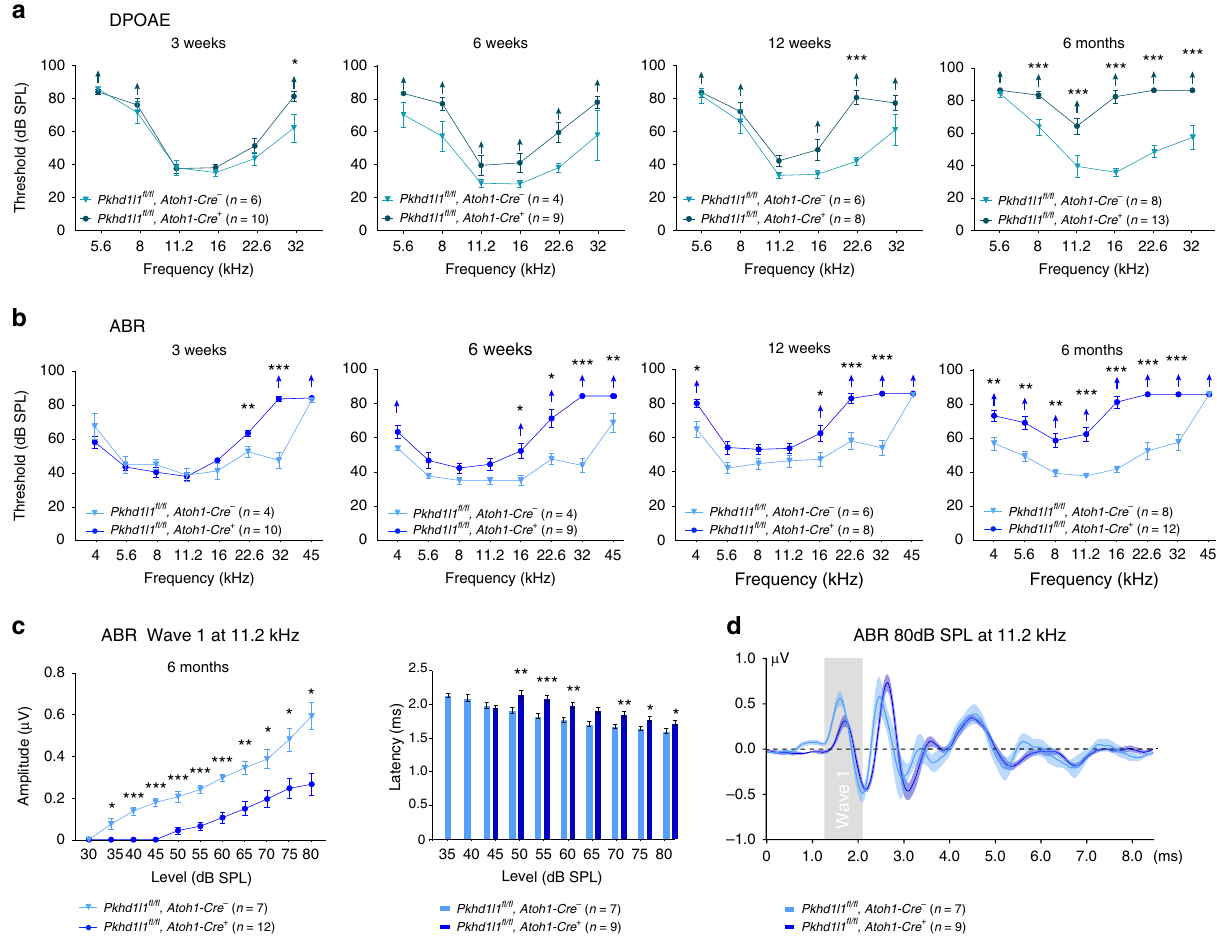
Fig. 7 Pkhd1l1 fl / fl , Atoh1-Cre + mice show progressive hearing loss. a , b DPOAE thresholds a and ABR thresholds b of Pkhd1l1 fl / fl , Atoh1-Cre − and Pkhd1l1 fl / fl , Atoh1-Cre + mice at 3, 6, 12 weeks, and 6 months show progressive hearing loss. Up-arrows indicate that even at the highest SPL test level (80 dB SPL), at least one mouse in the group had no detectable thresholds at that frequency. c Mean amplitude (left) and latency (right) as a function of sound intensity of 11.2 kHz pure tone pips in 6-month-old control Pkhd1l1 fl / fl , Atoh1-Cre − ( n = 7) and mutant Pkhd1l1 fl / fl , Atoh1-Cre + ( n = 12) mice. d Mean ABR waveforms in response to 11.2 kHz tone pips at 80 dB SPL from mutant ( n = 9) and control ( n = 7) mice. Data shown as mean ± s.e.m. * p < 0.05, ** p < 0.001, *** p < 0.0001; by two-tailed Student ’ s t test. Source data are provided as a Source Data fi